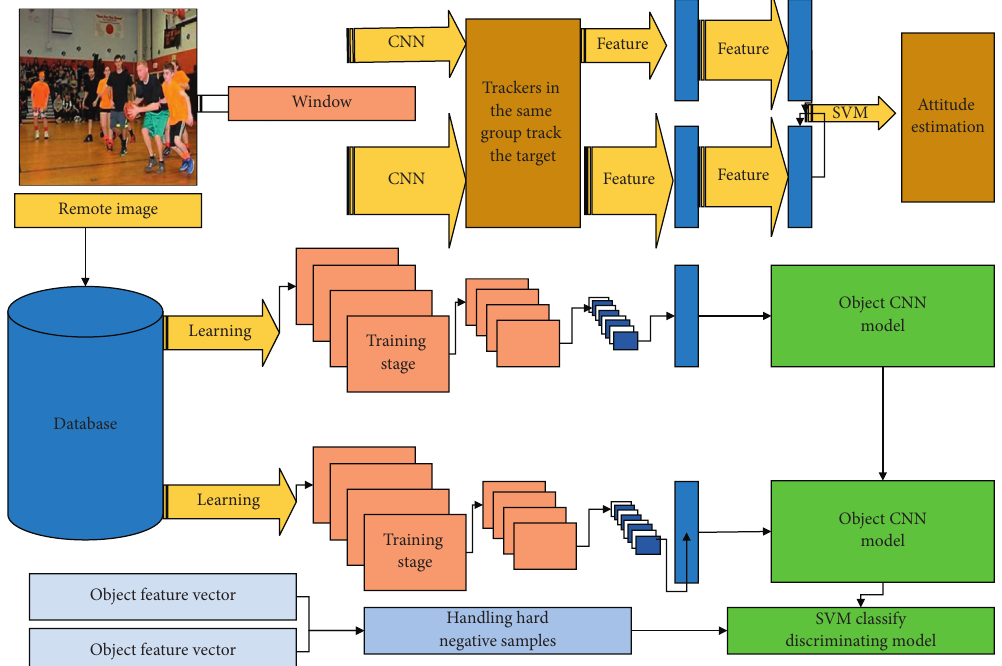
Figure 2: Basketball sports data real-time analysis system structure